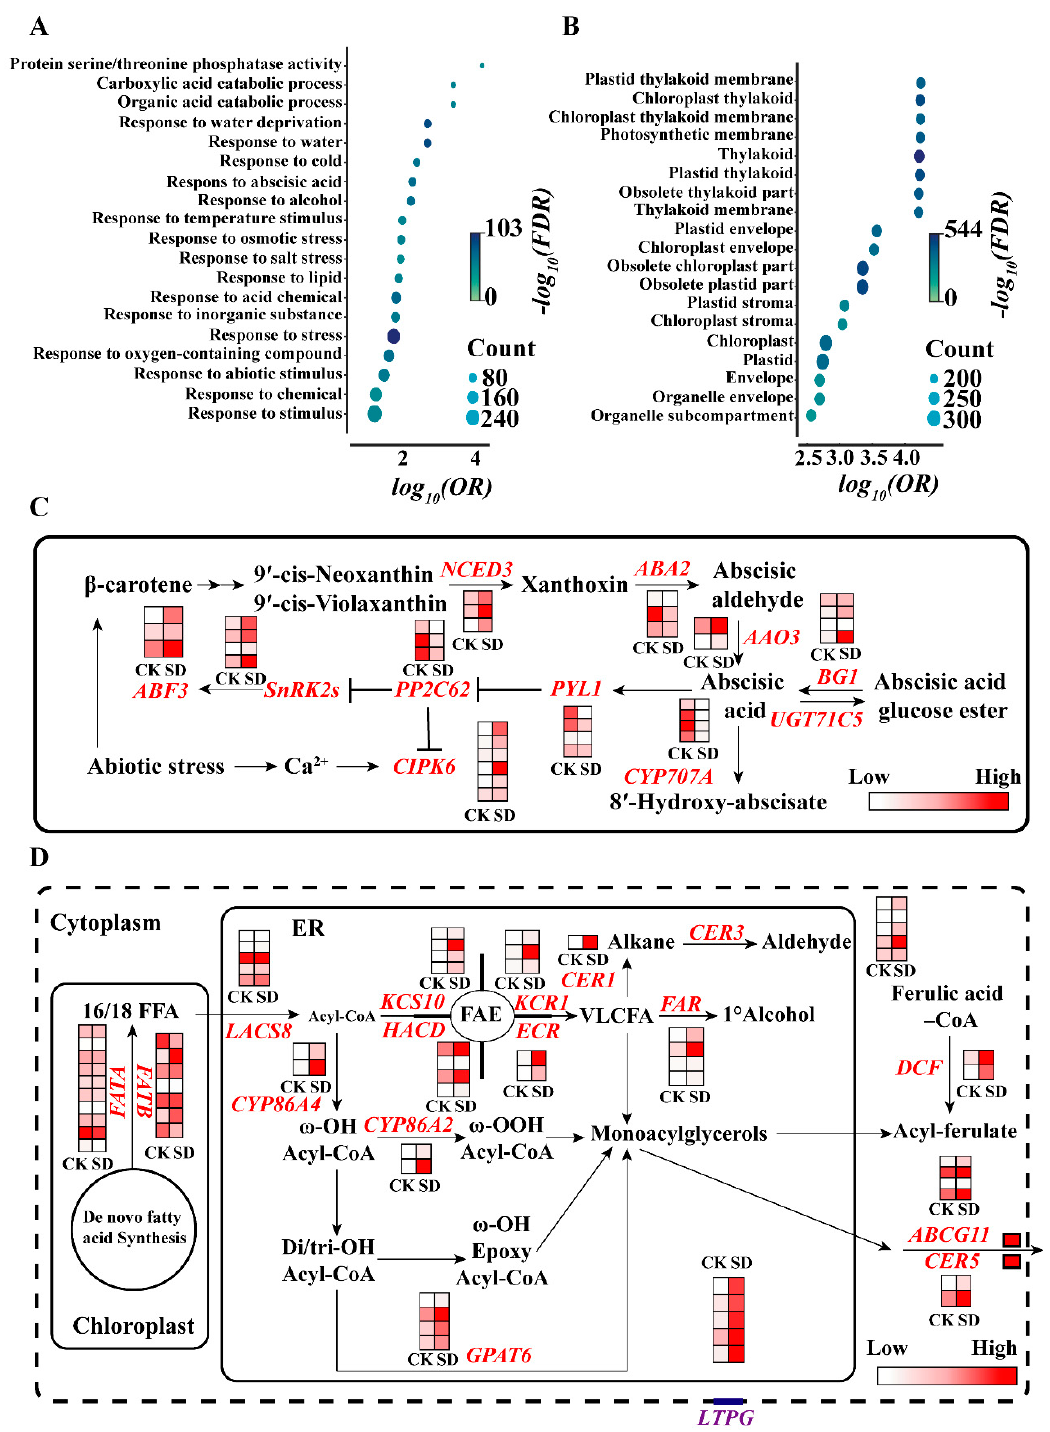
and dry weight under drought stress (Figure 5G). These results suggest that overexpression of BnaA01.CIPK6 enhances drought resistance in B. napus .